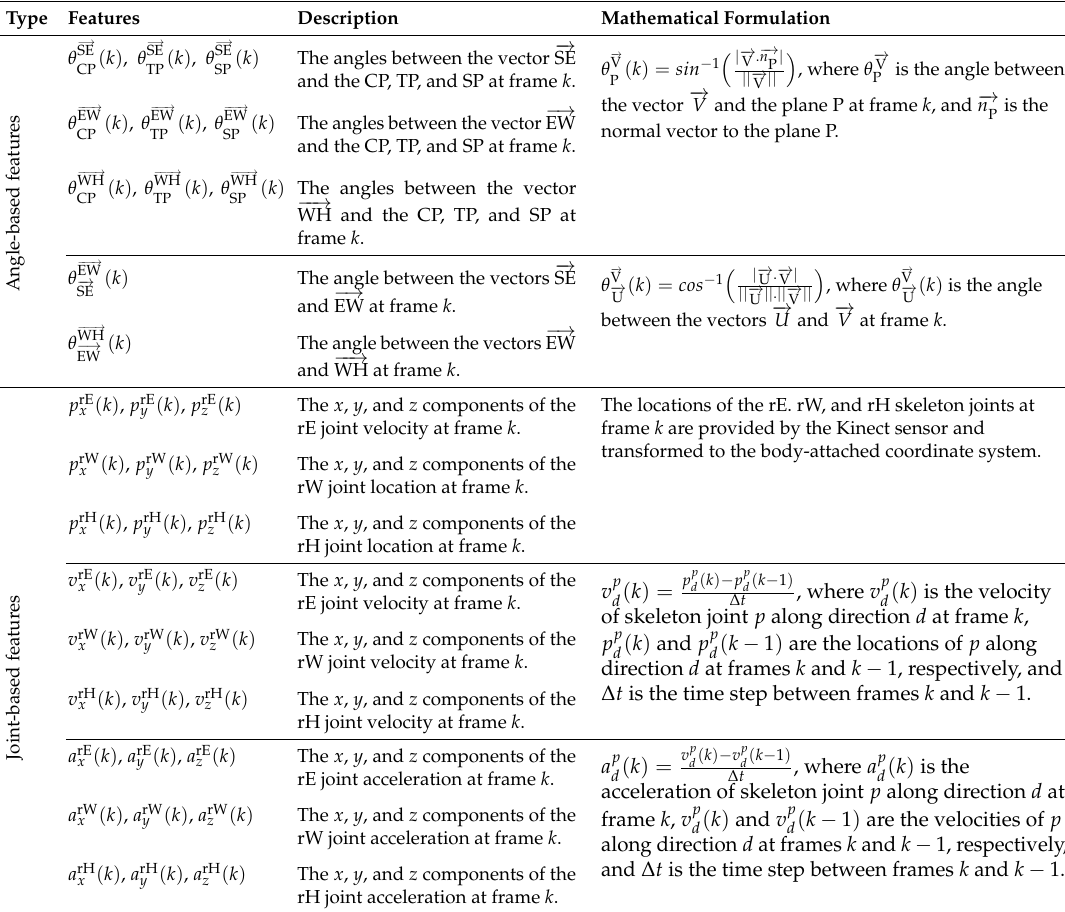
Table 1. The angle- and joint-based features of the